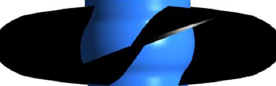
Figure 1. “S” shaped airfoil.